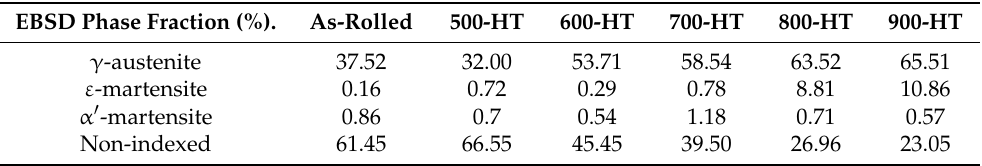
Table 2. EBSD phase fraction results of